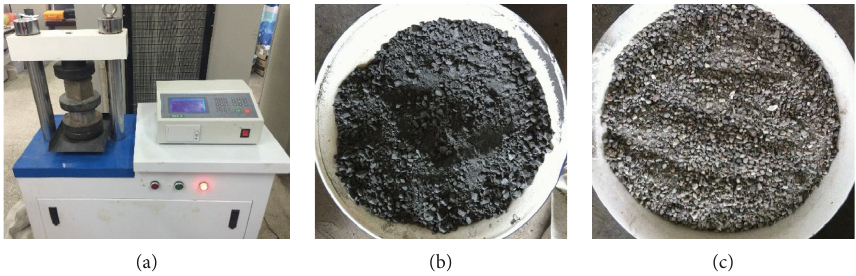
Figure 2: UCS tests and experimental samples. (a) UCS tests. (b) Tailings sample. (c) Waste sample.